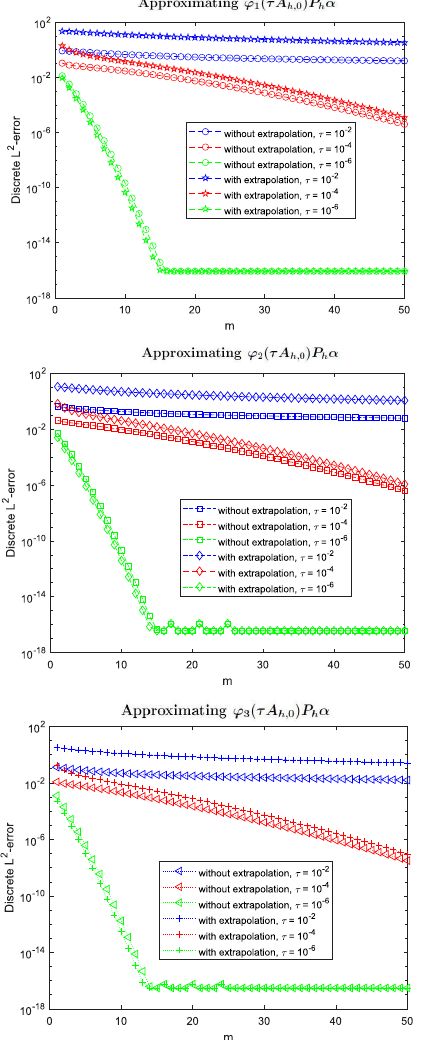
Figure 7. Discrete L 2 -error against number of Krylov iterations when approximating ϕ r + 1 ( τ A h ,0 ) P h α for the data in Section 2.1 for different values of τ with extrapolation (18) and without it, r = 0 ( top ), r = 1 ( middle ), r = 2 ( bottom ), ( h = 10 − 3